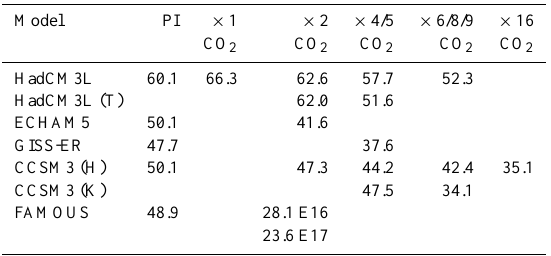
Table 3. Percentage of land surface characterised by extended sum- mer precipitation >55% MAP by model and by fractionation CO 2 increase from preindustrial (PI)